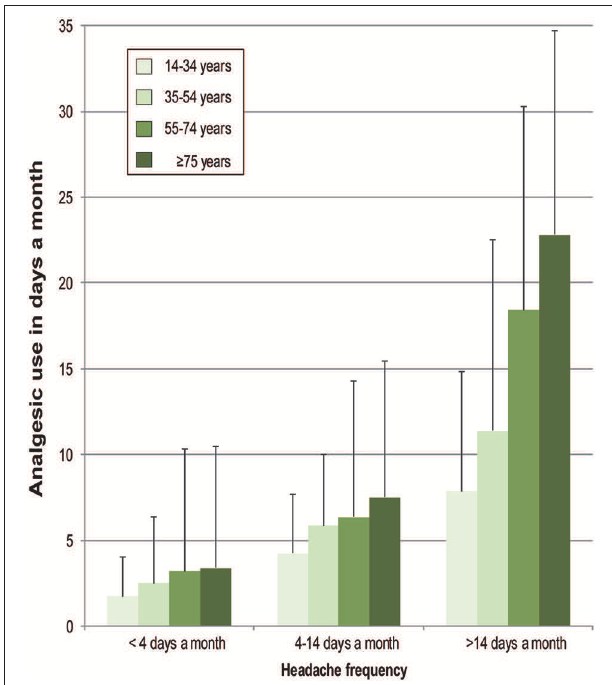
FIGURE 3 | Frequency of analgesic use (days a month) depending on frequency of headache and age